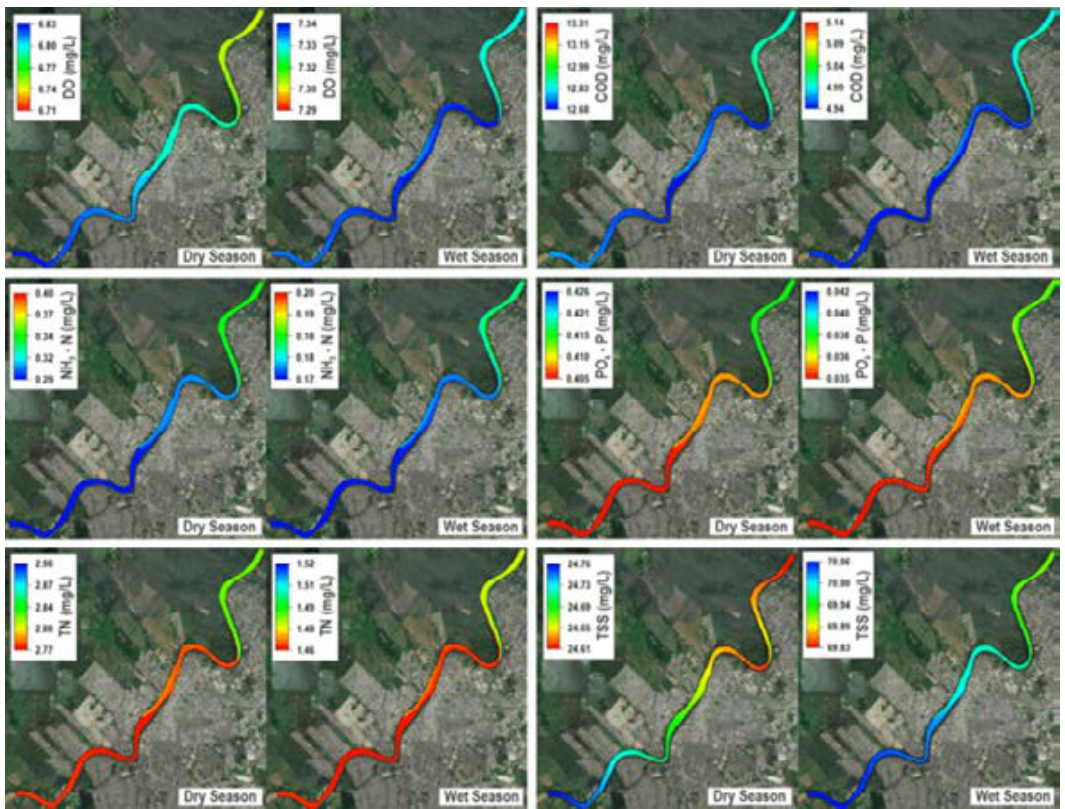
Fig. 7: Simulation results of physicochemical parameters in dry (March 31st) and wet (October 26th) seasons (Note the change of scale in the figures)